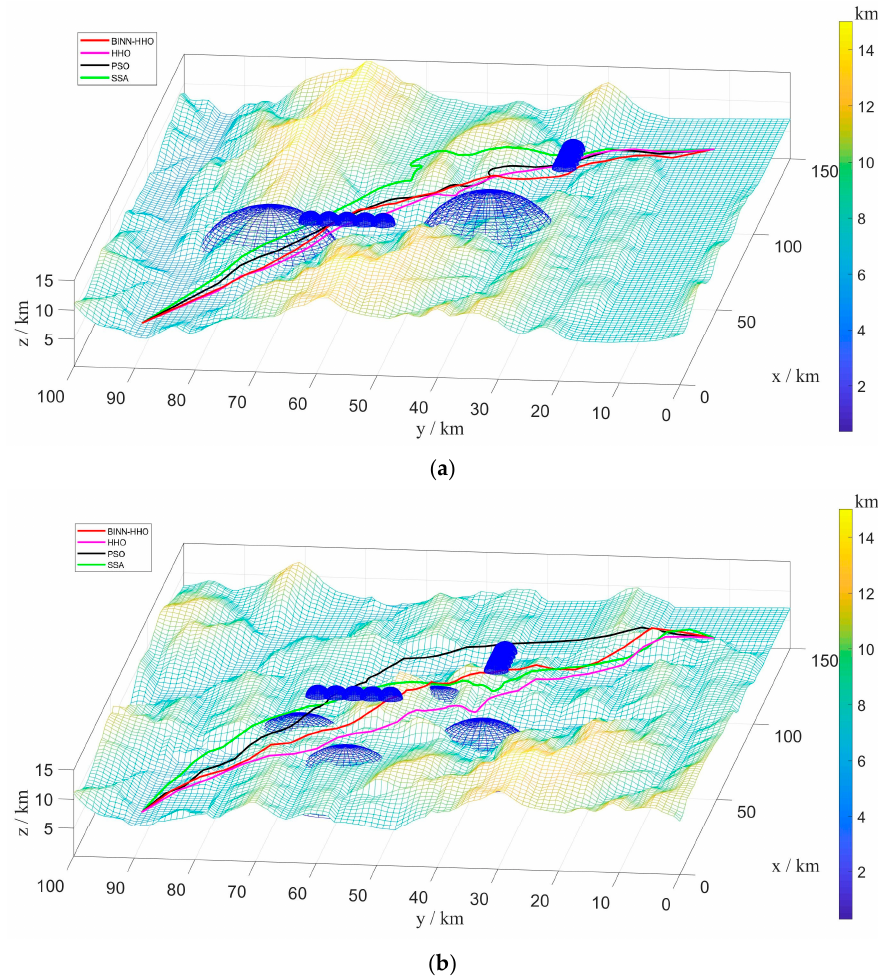
Figure 12. Single-UAV path planning results of BINN-HHO on a 3D simulation map. ( a ) Dynamic case I. ( b ) Dynamic case II.